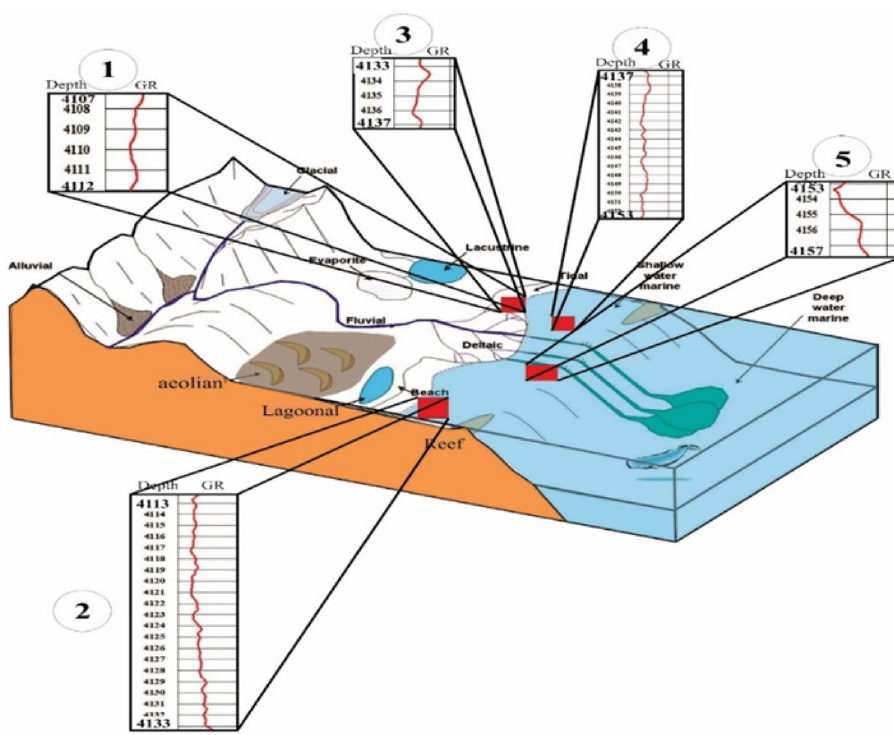
Fig. 21 Depositional model for Lockhart limestone of Meyal- 05P. The log trends are from GR